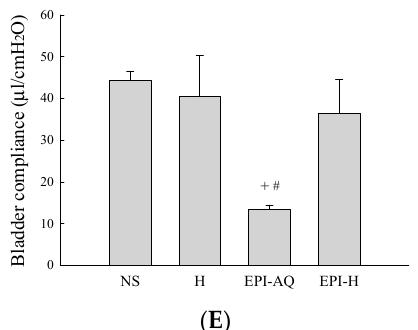
Figure 4. Effects of intravesical epirubicin on voiding function in the rat. ( A ) Representative tracings of cystometrograms (CMG) recorded from F344 rats following intravesical instillation of normal saline (NS), H, EPI-AQ, and EPI-H. Urodynamic parameters after treatments were ( B ) peak micturition pressure (cmH 2 O); ( C ) threshold pressure (cmH 2 O); ( D ) micturition duration (s); and ( E ) bladder compliance ( μ L/cmH 2 O). Data are mean ± S.D. + p < 0.05 compared with NS. # p < 0.05 compared with H. * p < 0.05 compared with EPI-AQ.